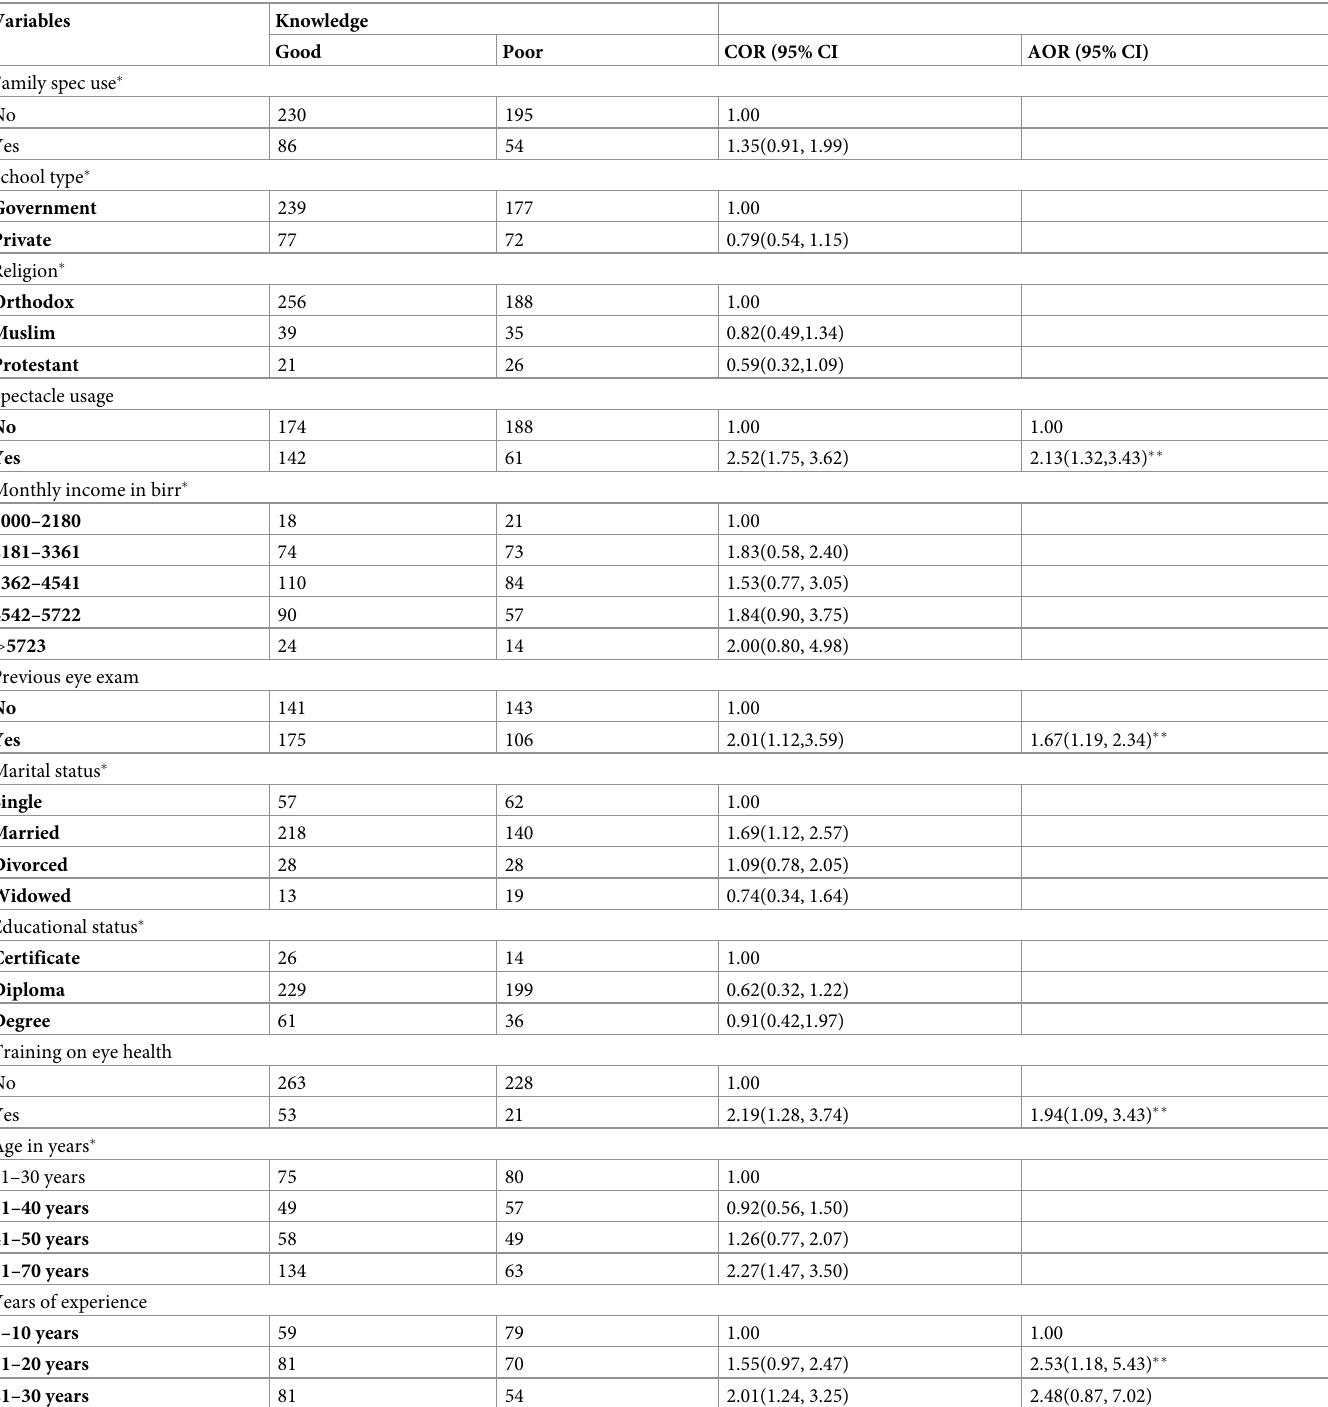
Table 3. Factors associated with knowledge of study participant regarding a refractive error in school children in Gondar city, Northwest Ethiopia, 2017.